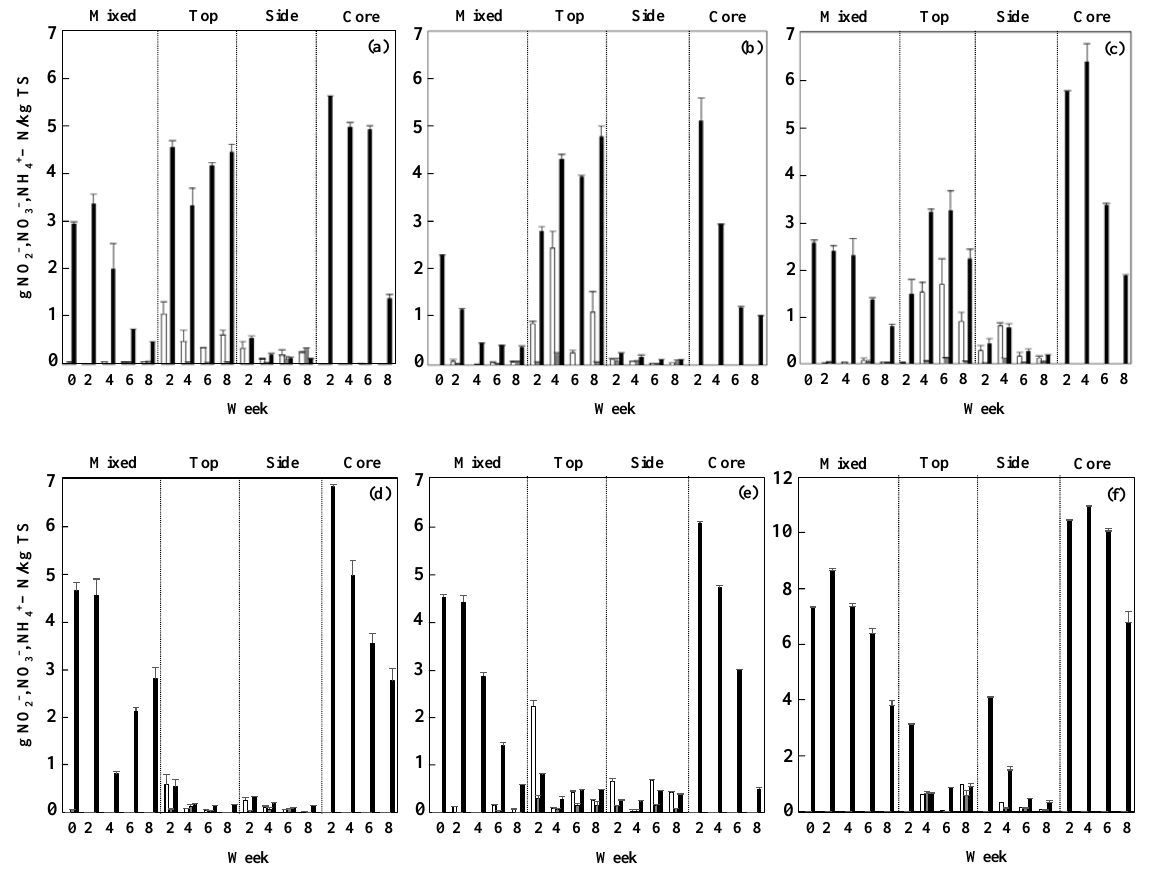
(grey) and NH + –N (black) content of the compost samples from each location (top, side and core) of the Figure 1. NO − (white), NO − 2 3 4 pile and the sample just after the turnings (mixed). These contents were determined every 2 weeks, just before/after the turning events. (a) – (c) indicate the pile 1 of the compost runs 1–3, and (d) – (f) indicate the pile 2 of the compost runs 1–3, respectively. The error bars indicate the standard deviation ( n =